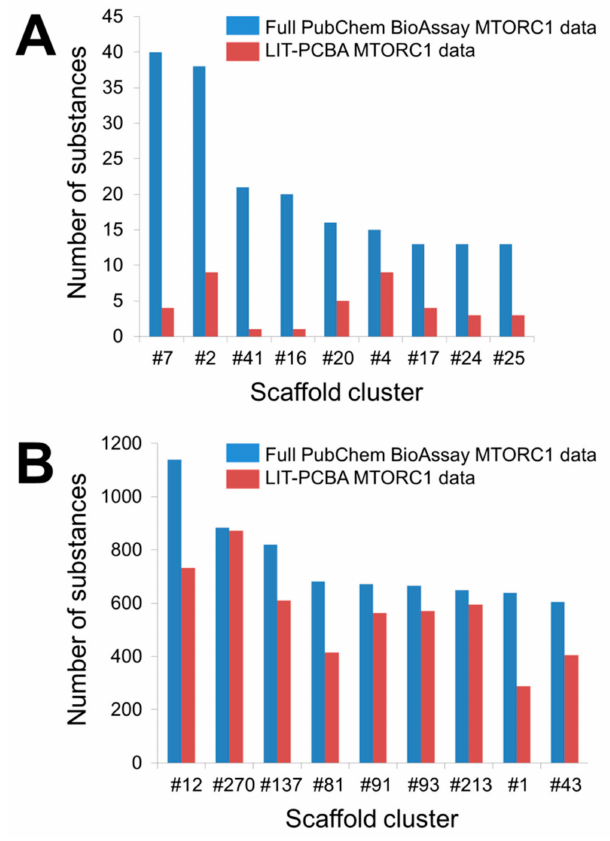
Figure 5. Number of substances falling into each sca ff old cluster that includes more than 10 true active molecules ( A ) or 600 true inactive molecules ( B ). Bemis-Murcko frameworks derived from the input molecules were first created by trimming each active and each inactive separately with Pipeline Pilot 19.1.0.1964 [94,95]. A hierarchical sca ff old tree consisting of canonical SMILES (simplified molecular-input line-entry system) strings that represent the rings, linkers, and double bonds in each molecule was next generated according to an iterative ring-trimming procedure described by Schu ff enhauer et al. (2007) [96]. All ligands were then clustered based on the smallest sca ff old at the root of the sca ff old tree for each ligand. The number that follows each hash symbol indicated in this figure refers to the ordinal number of a sca ff old cluster as issued by Pipeline Pilot. Details of all clusters can be found in the Supplementary Materials (Tables S3 and